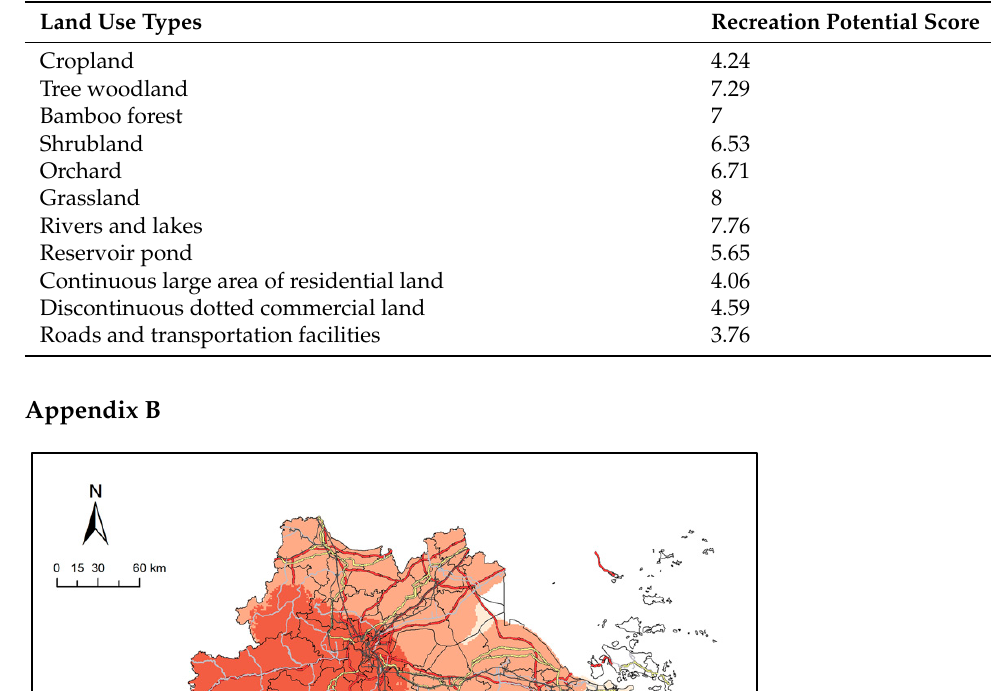
Table A1. Recreation potential scores of land types in Qianjiangyuan National Park.